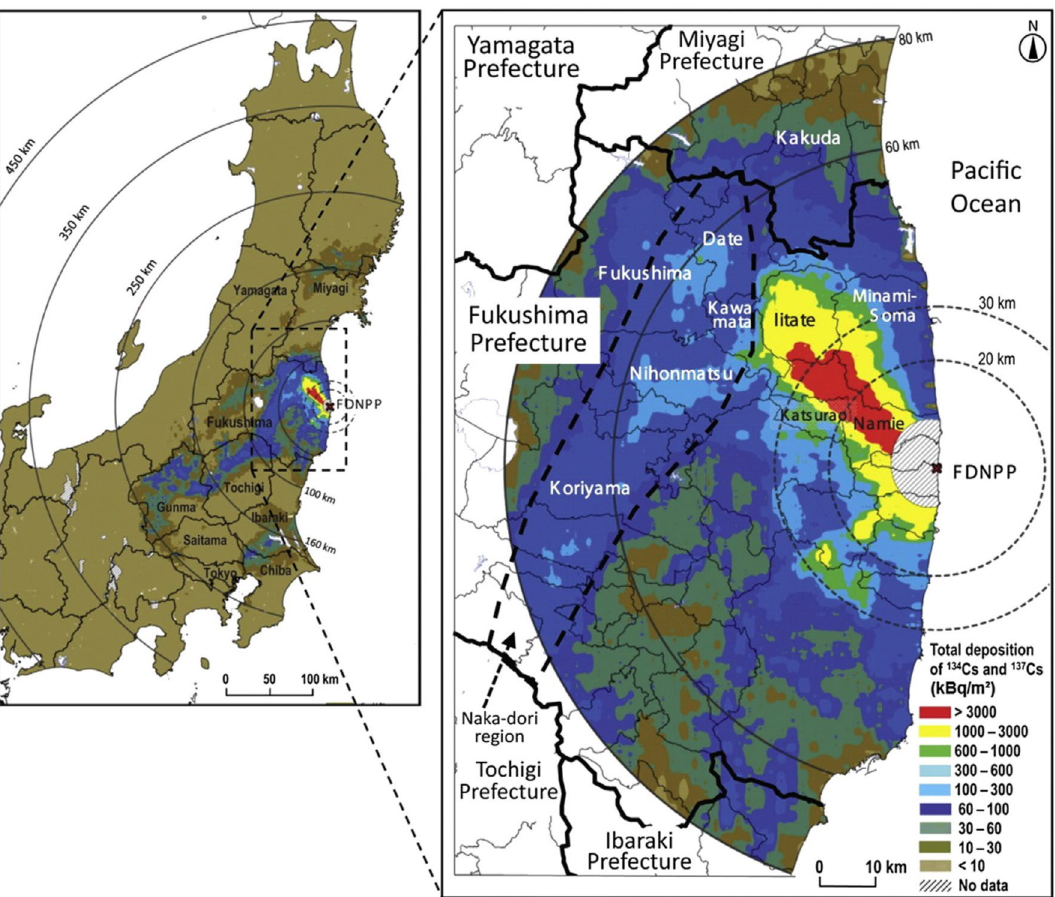
Figure 2. Estimated total distribution of radiocaesium after the FDNPP accident. The narrow red band corresponds to the highest activity region of the primary containment plume that was released north west from Unit 2 of the FDNPP 9 . Adapted from 20 .